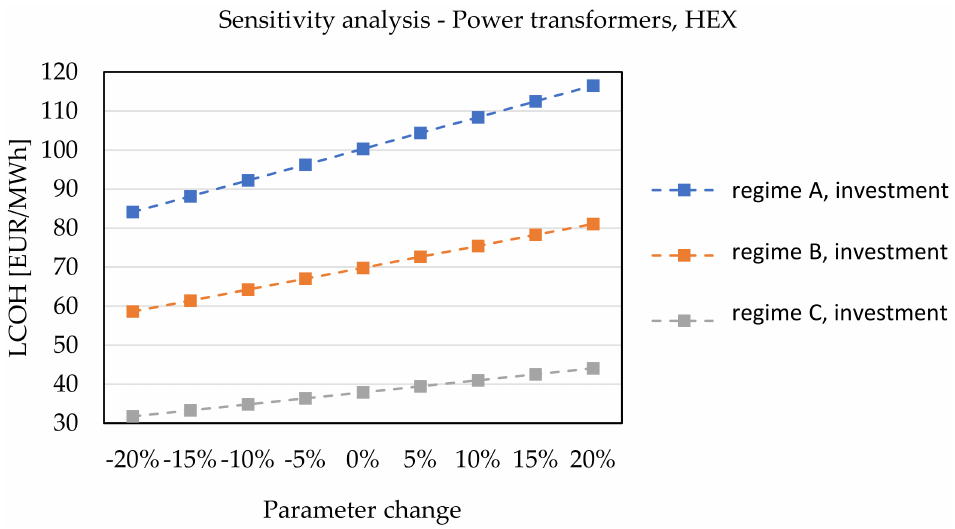
Figure 25. Sensitivity analysis for different DH network temperature regimes—power substation waste heat, utilization technology heat